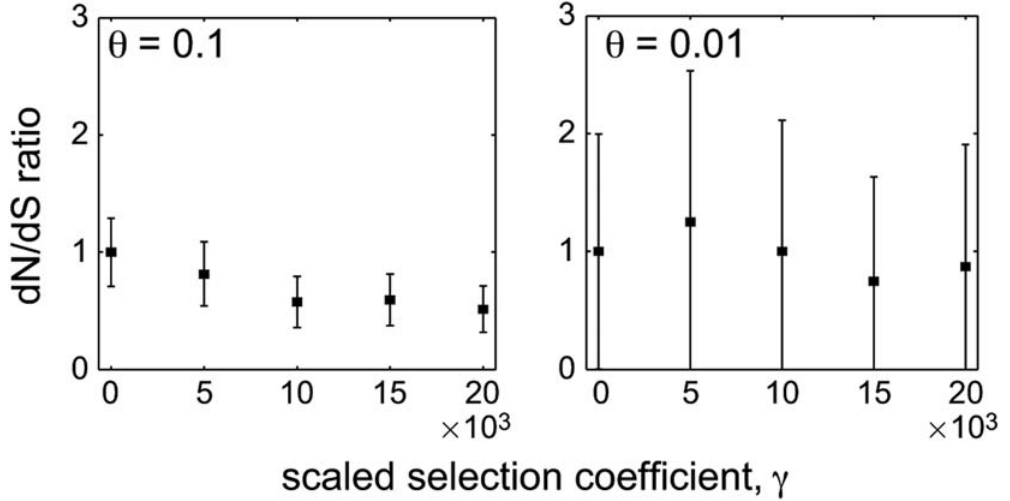
Figure 2. The behavior of the within-population dN/dS ratio for large c in simulated Wright-Fisher populations. Black squares show the mean 6 two standard errors of the observed dN/dS ratio. Left panel shows results for h =0.1; right panel shows results for h =0.01. Simulations were performed at L =10 3 independent sites.